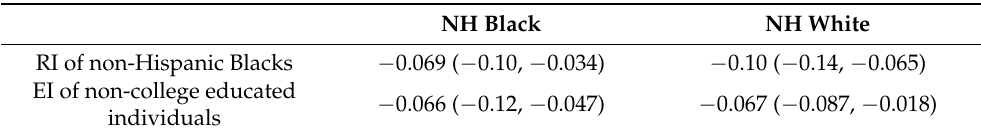
Table 2. Associations between gestational age in weeks and racial isolation and educational isolation a